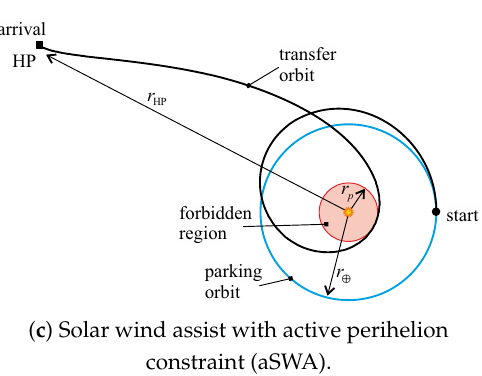
Figure 5. Three types of optimal transfer to HP in a simplified two-dimensional